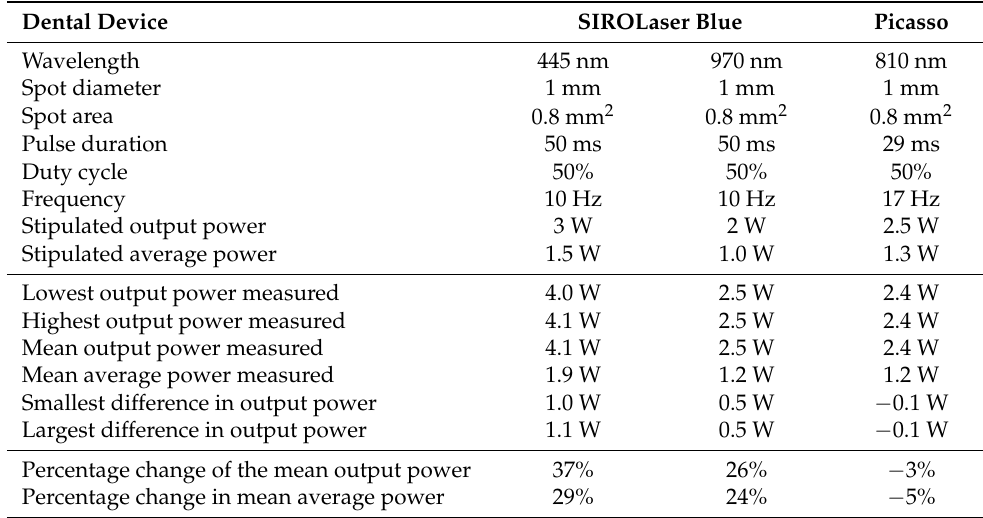
Table 2. Parameters stipulated and actual power of laser devices in pulsed mode. Dental